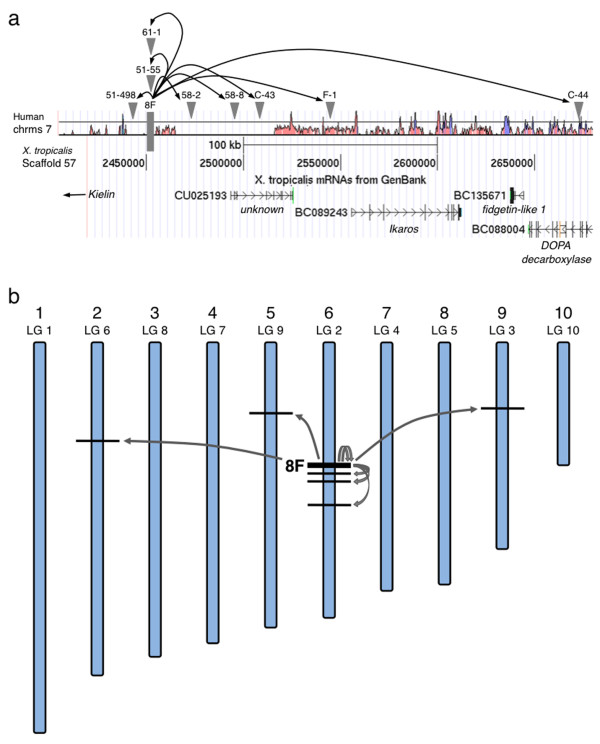
Schematic representation of remobilized SB transposons in the X. tropicalis genome. (a) Local hopping on X. tropicalis chromosome 6 depicts the integration sites for eight local (< 200 kb) remobilization events (hops). (Not to scale.) This region of X. tropicalis chromosome 6 is syntenic with human chromosome 7. The Vista http://genome.lbl.gov/vista alignment shows regions of homology between the frog and human genomic sequences; pink represents non-coding regions and blue represents conserved exons. The position of the 8F donor concatemer is indicated by the grey box. The remobilized transposition events are depicted by the grey triangles. The position and orientation of predicted genes near the 8F locus are depicted in the lower section of the panel. (b) Schematic representation of the X. tropicalis chromosomes indicating the distribution of remobilized SB transposons. The parental 8F donor site is on chromosome 6 (thick line). The predicted loci of the remobilized transposons are depicted by the thin black lines. Approximately 80% of the remobilization events occur near the donor locus (local hopping), and the remaining 20% are distributed randomly throughout the genome. SB: Sleeping Beauty.